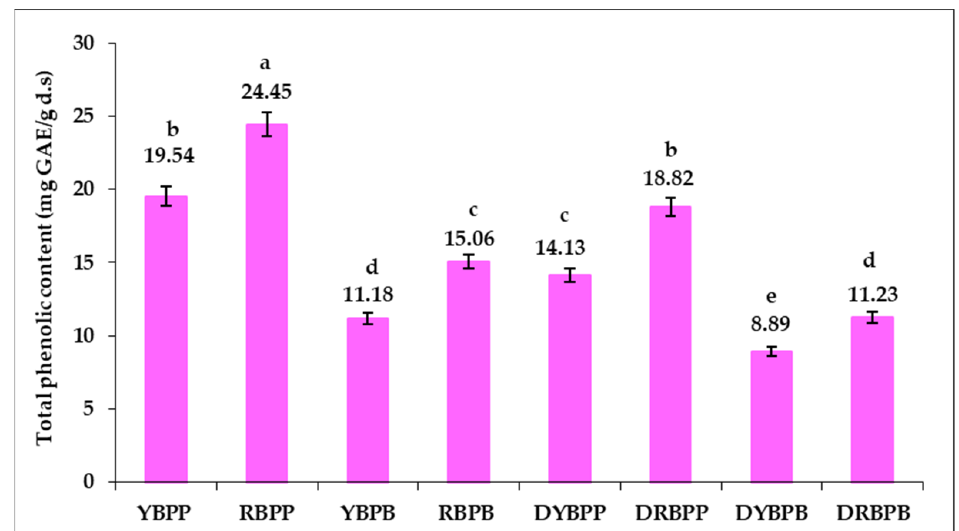
Figure 1. Total phenolic content (TPC) of yellow and red bell pepper pulp and processing by-products, fresh and after drying. The results are expressed as the average value of three determinations ± the standard deviation (SD) indicated by the error bars. According to t -test, the different letters (a–e) represent the significant differences ( p < 0.05) between the values represented in the columns.